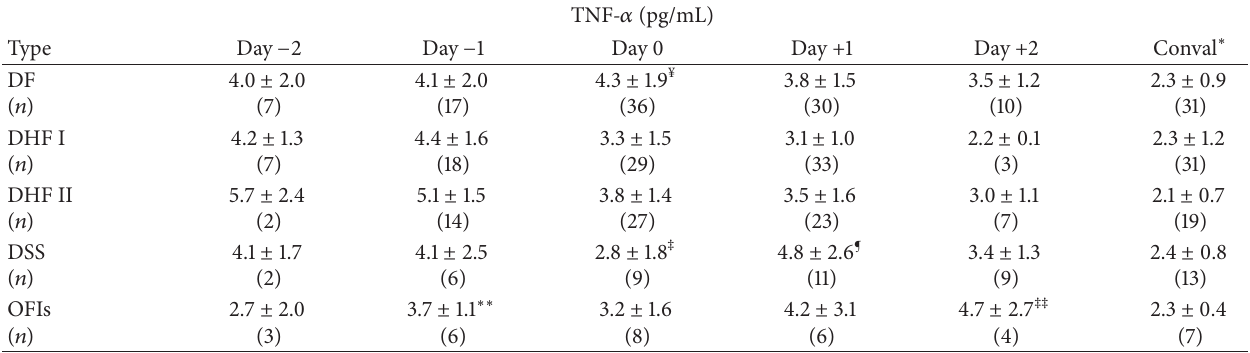
Table 6: Mean ± SD of the level of tumor necrosis factor-alpha (TNF- 𝛼 ) in patients with DF, DHF grades I and II, DSS, and OFIs patients, followed by the day of illness related to fever.